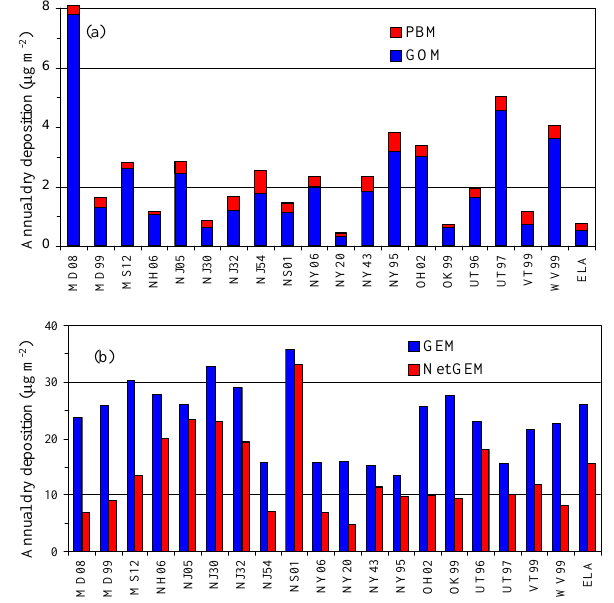
Fig. 3. Annual average speciated dry deposition fluxes (µgm − 2 ). Net GEM flux is the GEM dry flux minus GRAHM modeled annual GEM re-emission and natural emission